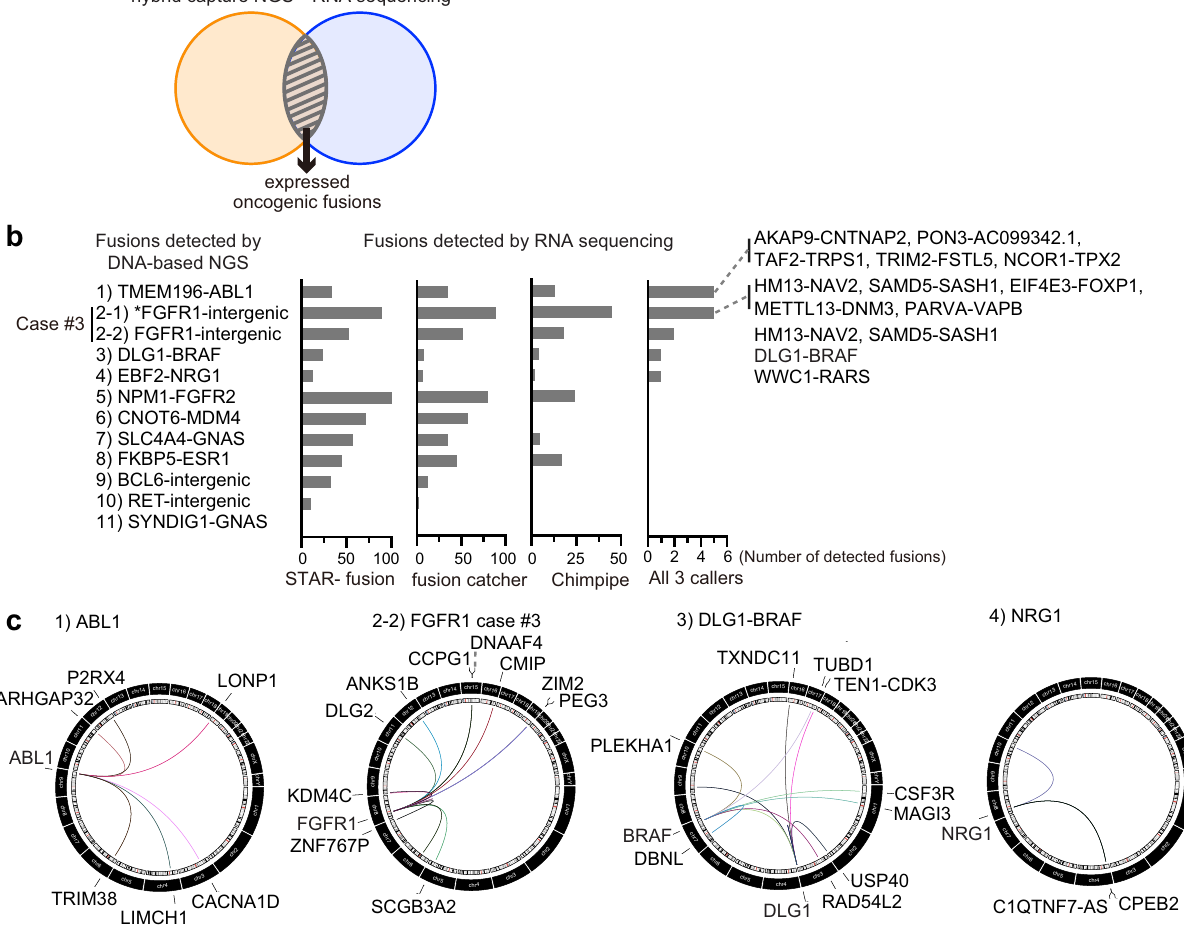
detected by all three fusion callers were noted. Asterisk points to data obtained from the leftover RNA sample from the RNA-based anchored multiplex PCR for targeted NGS. c Circos plots showing discordant reads with ABL1 , FGFR1 , BRAF , DLG1 , or NRG1 detected by